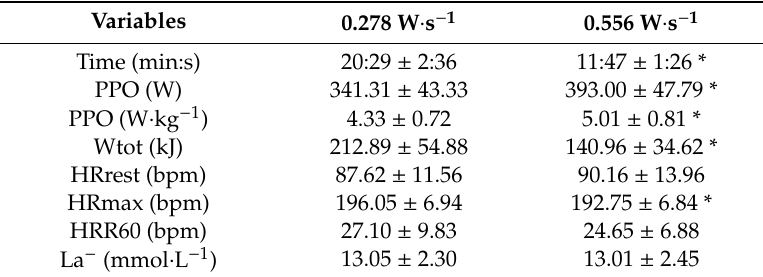
Table 2. Variables attained in the incremental tests (x ± SD).